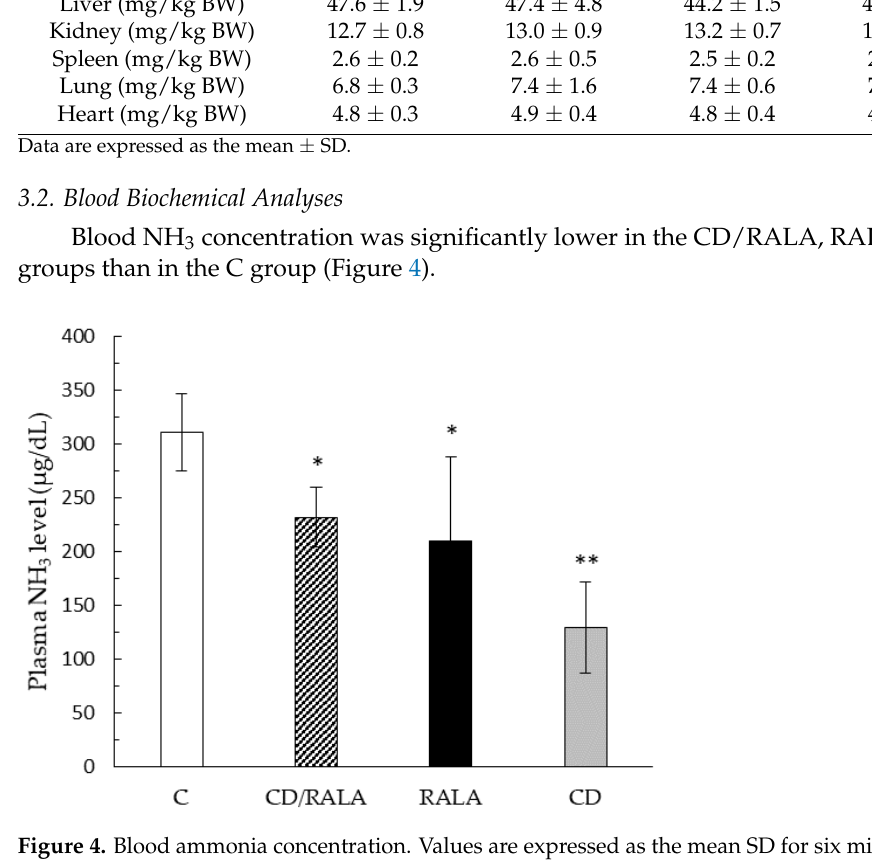
Figure 4. Blood ammonia concentration . Values are expressed as the mean SD for six mice. C, control group; CD/RALA, R- α -Lipoic acid γ -cyclodextrin complex group; RALA, R- α -Lipoc acid group; CD, γ -cyclodextrin group. ** p < 0.01 vs. C. * p < 0.05 vs. C.